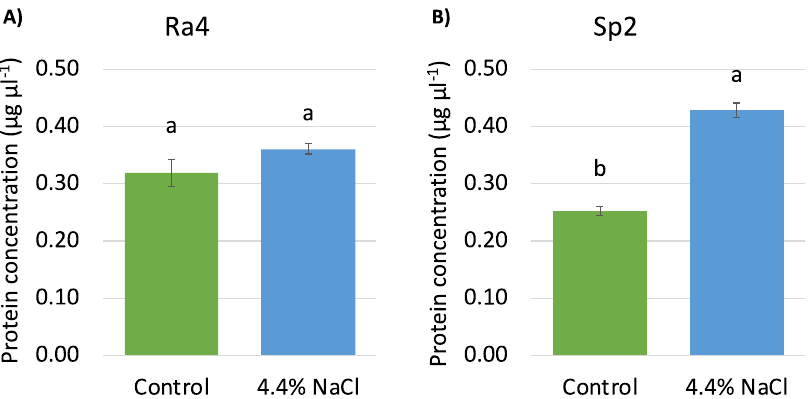
Figure 4. Quantification of proteins (concentration µg µL −1 ) (precipitated from the growth supernatant); Control: bacteria growth for 24 h under shaking in TSB medium at 28 °C; treated cells: bacteria grown in TSB medium added with 4.4% NaCl at 24 h of incubation (28 °C in shaking): ( A ) Rahnella aquatilis Ra4; ( B ) Serratia plymuthica Sp2. Different letters indicate statistically significant differences between values in 4.4% NaCl in respect to control ( p -value < 0.05).